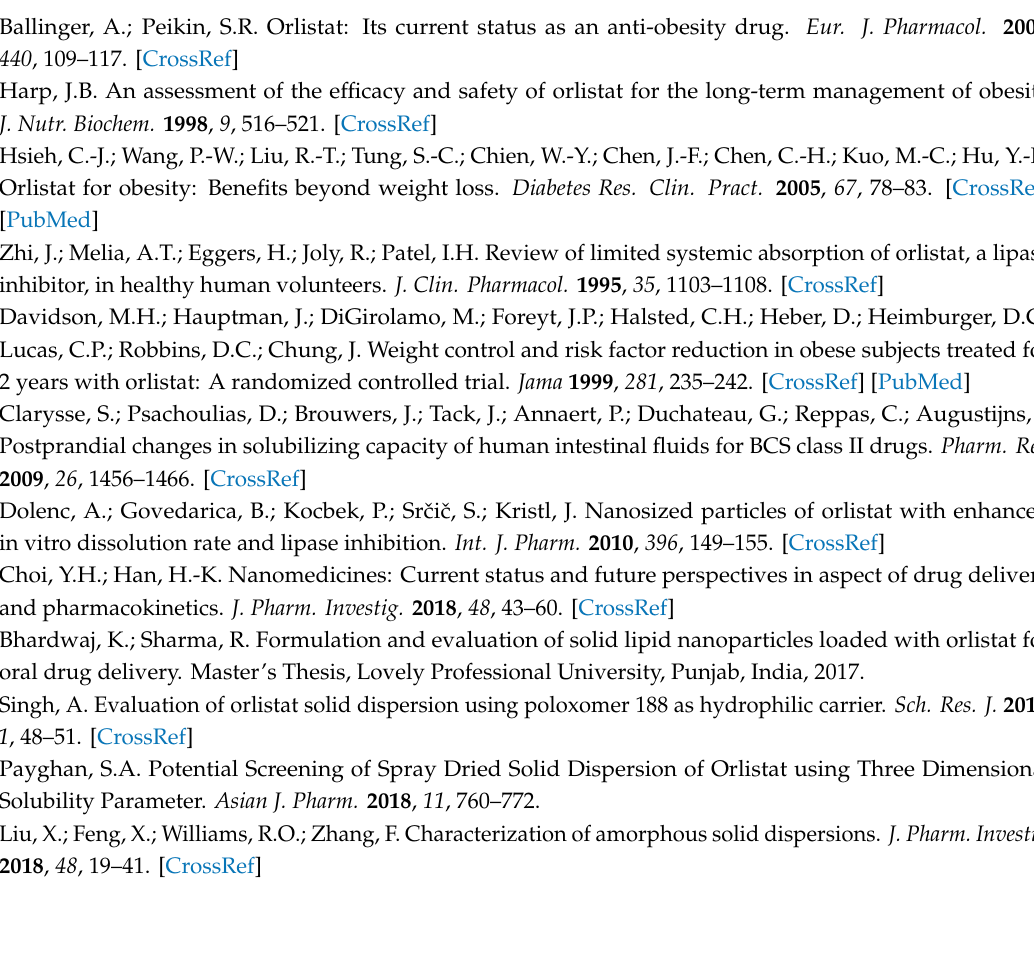
Figure S1: Comparison of the solubility data for fenofibrate in supercritical carbon dioxide at 318.2 K reported in the literature and this work, Figure S2: Dissolution profiles of orlistat-loaded Neusilin ® UFL2: (a) e ff ect of pressure; (b) e ff ect of temperature; and (c) e ff ect of orlistat mass ratio for MA-SCF process; and (d) e ff ect of preparation method. 1N:O is the mass ratio of Neusilin ®